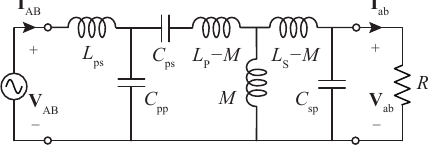
Figure 2. An LCC-parallel compensated inductive power transfer (IPT) system.